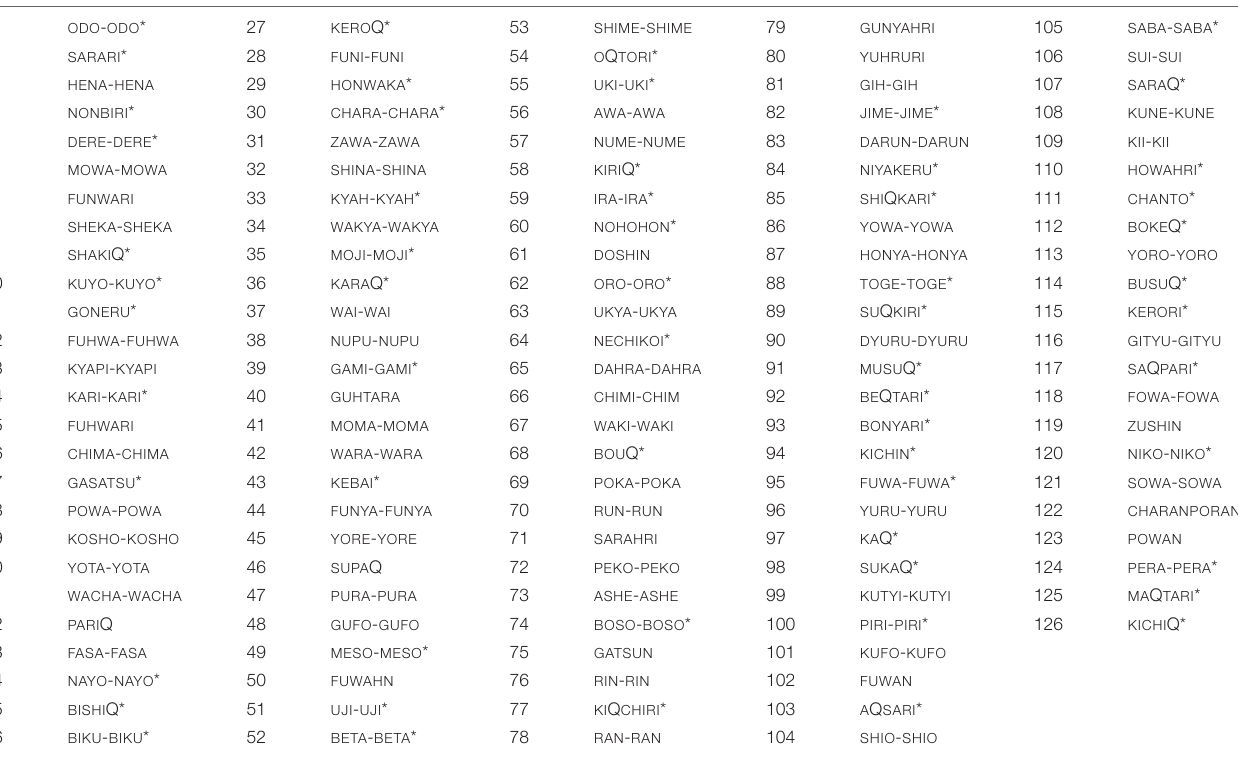
TABLE 1 | All 126 sound-symbolic words (SSWs) used in the experiment (SSWs used in the study by Komatsu are shown with